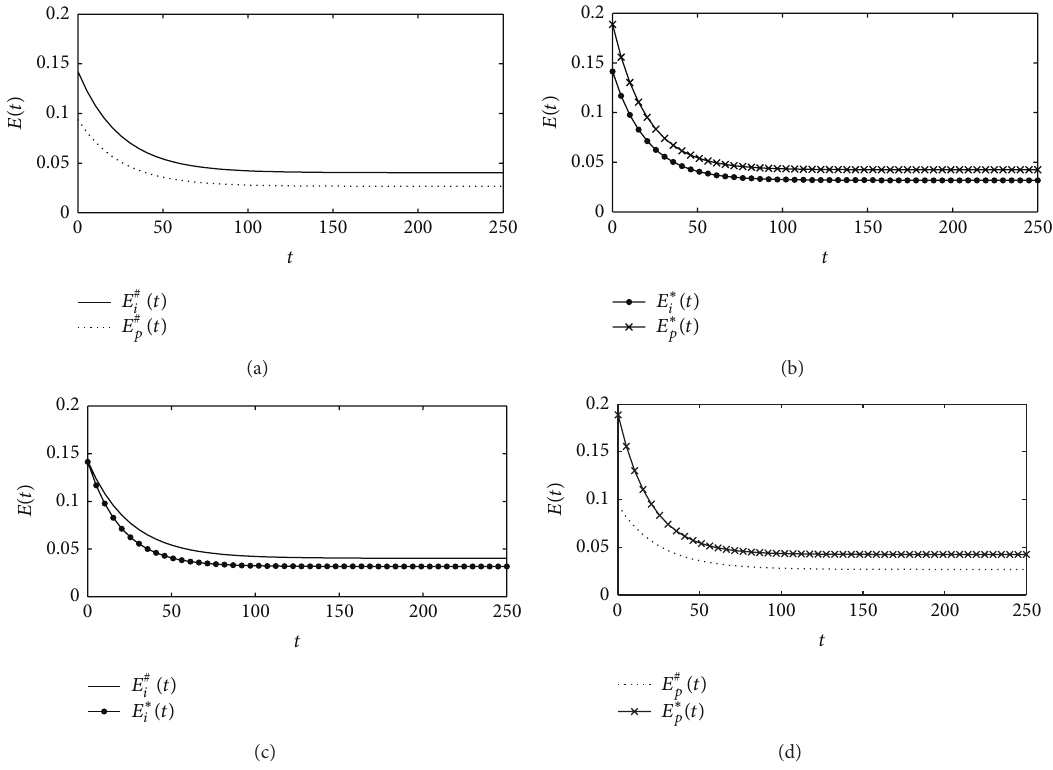
Figure 1: Difference of optimal efforts between Nash equilibrium and Stackelberg